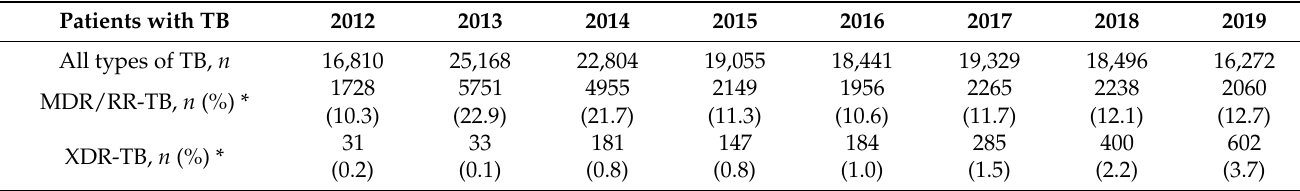
Table 5. Number of patients with all types of TB and the number with laboratory-confirmed MDR/RR-TB and XDR-TB in Uzbekistan from 2012 to 2019.